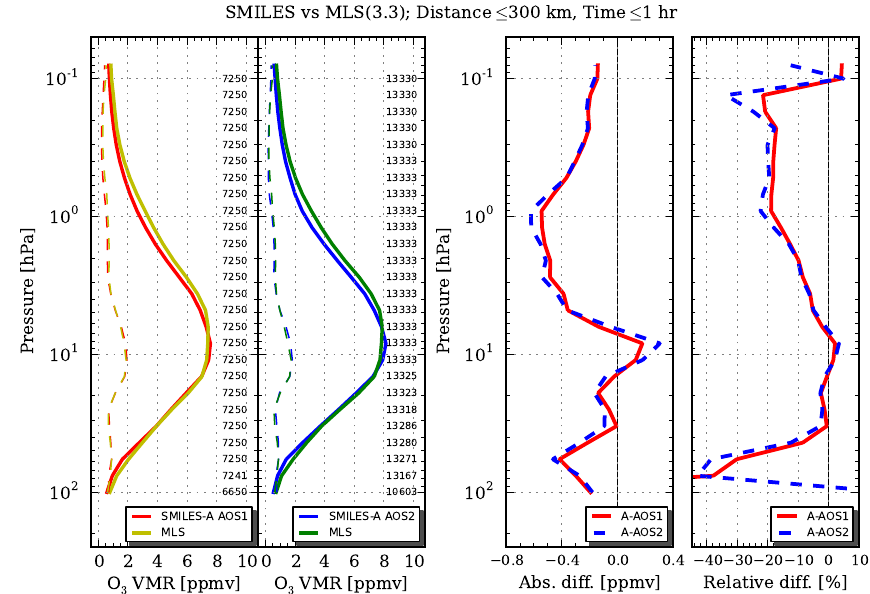
18 Y. Kasai et al.: SMILES O 3 validation (NICT L2-v215) Fig. 14. Same as Fig. 13, except we selected the SMILES data only for Band-A and distinguished the two different AOSs used. while Fig. 8 was created using using only equatorial data,